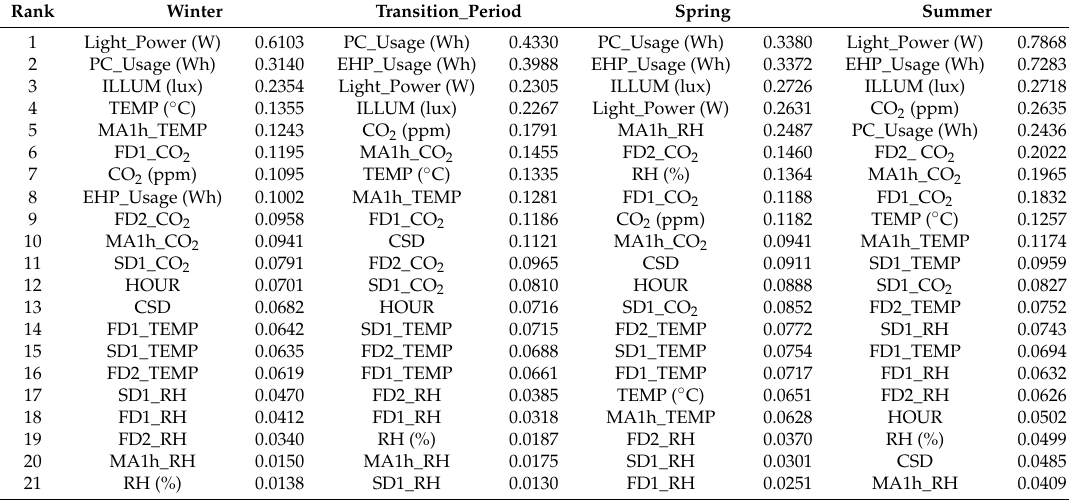
Table 7. Evaluation results of seasonal input variables’ influence based on the gain